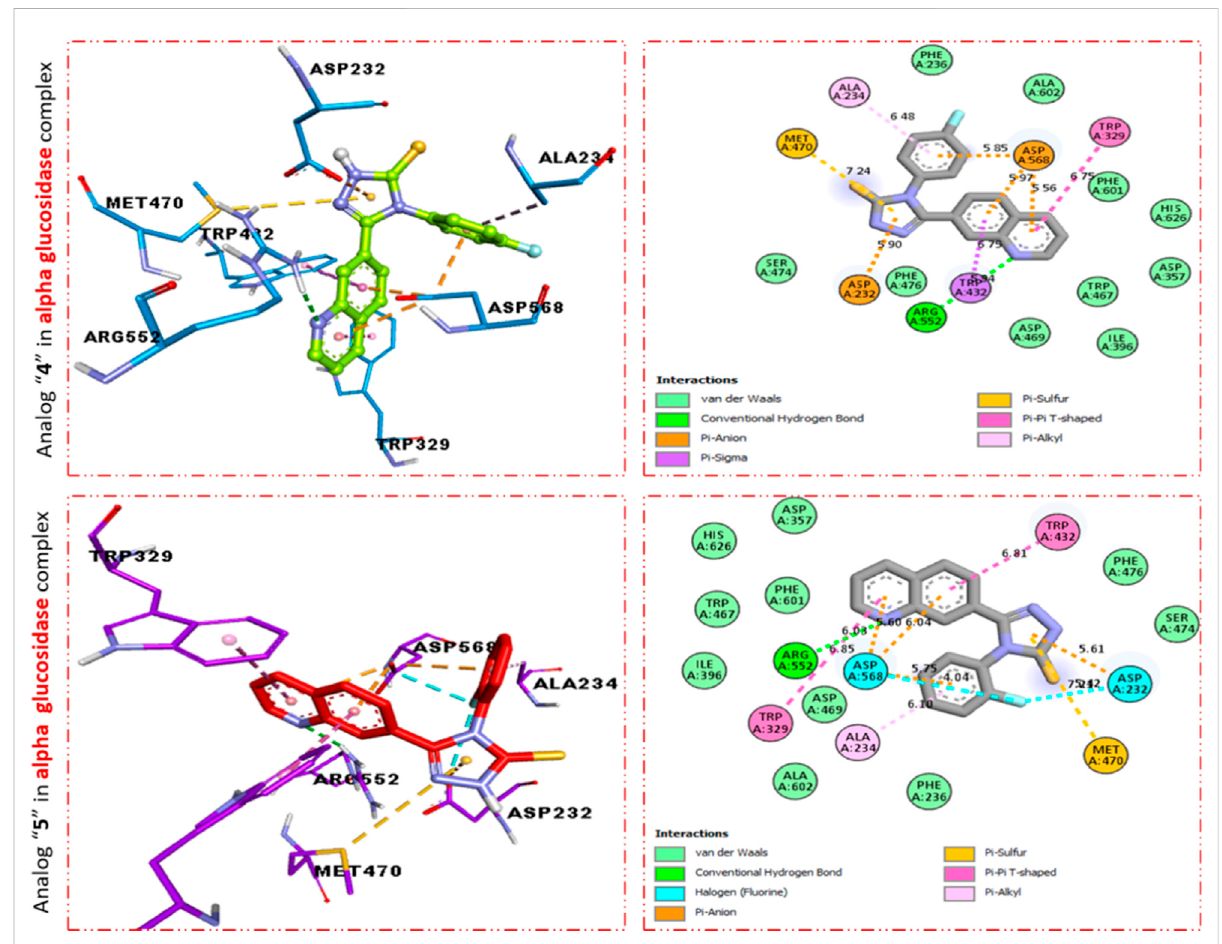
FIGURE 4 PLI pro fi le indicates the corresponding surface of α -glucosidase enzyme and its interactions with fl uoro-substituted scaffolds 11 d and